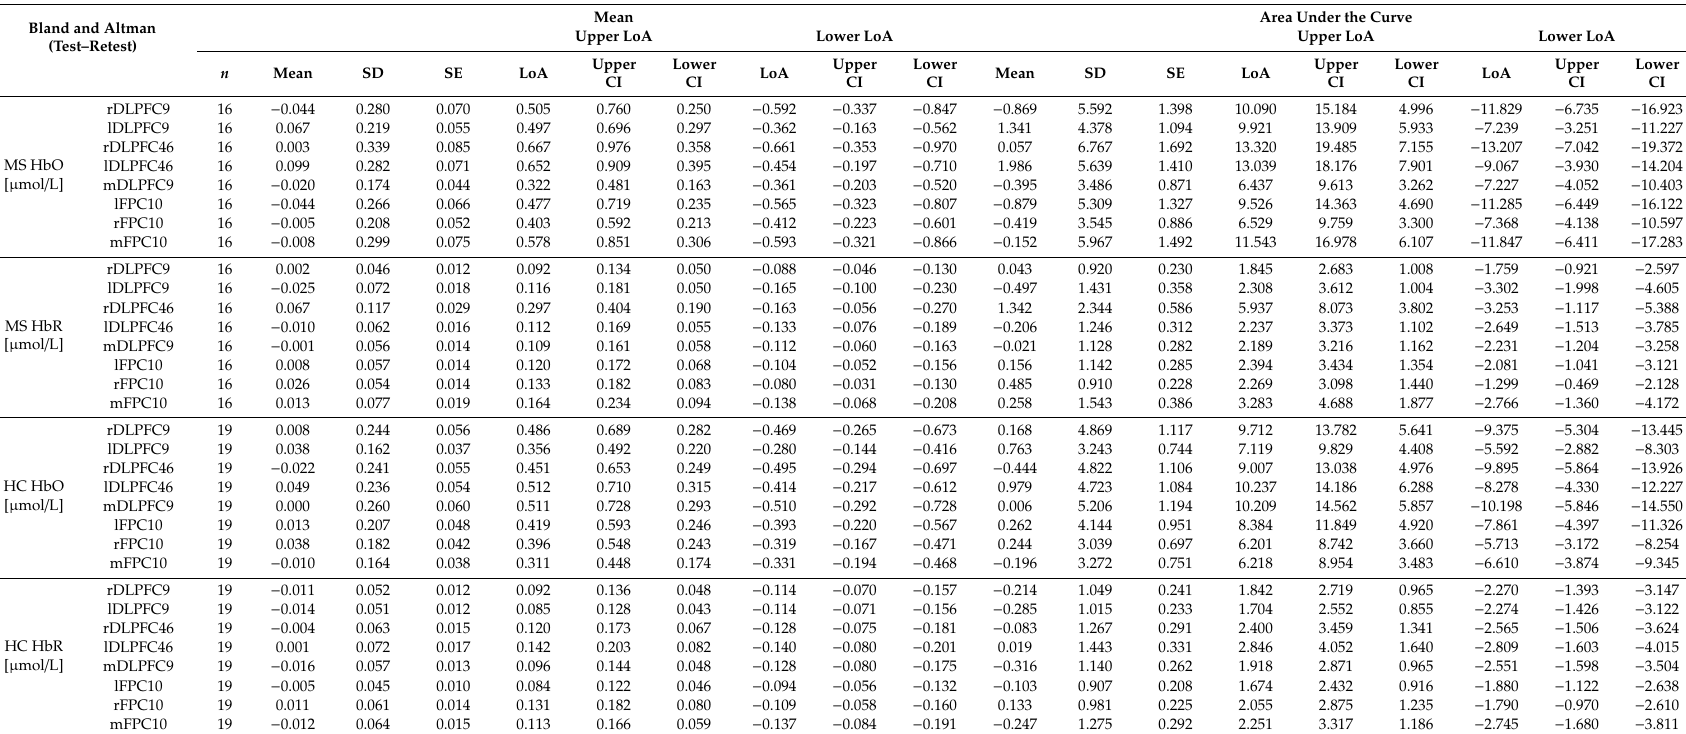
Table 4. Bland and Altman limits of agreement, bias and confidence intervals of both groups (MS / HC). Bland and Altman